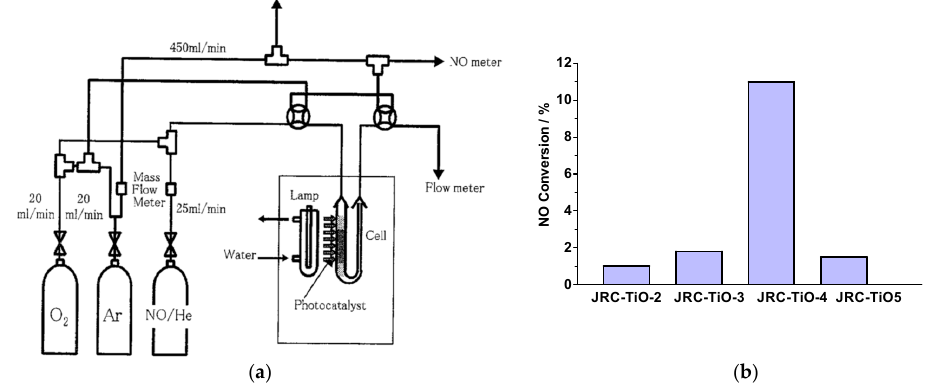
Figure 19. ( a ) Flow system for the photocatalytic reaction of NO x . Conditions: 150 mg TiO 2 ; NO reactant gas (NO + He), 10 ppm; flow rate, 100 mL min − 1 ; irradiation time, 2 h; Toshiba SHL-100UV high-pressure Hg lamp; color filter, UV-27 ( λ > 270 nm). ( b ) Conversion of the photocatalytic decomposition of NO on the standard reference TiO 2 photocatalysts at room temperature; adapted from Ref. [104]. Reproduced with permission from Zhang et al. [104]. Copyright 2001 by Academic Press (License No.: 4452650162755).